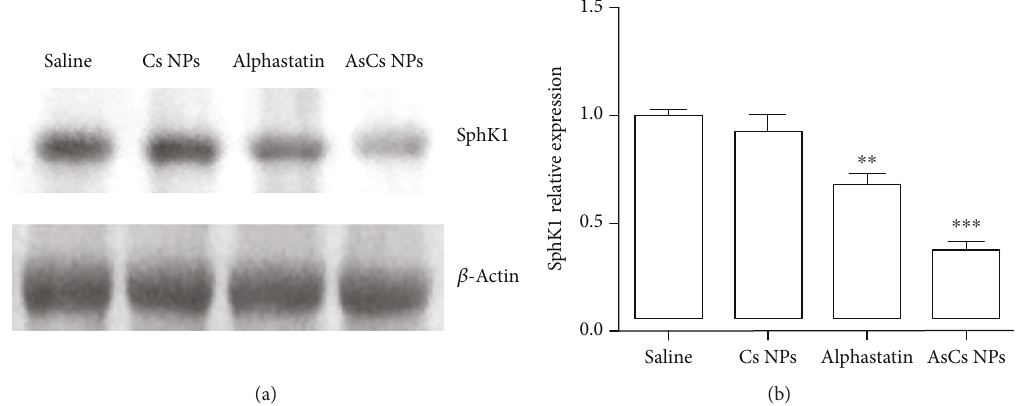
Figure 8: The downregulated SphK1 expression by AsCs NPs was detected by western blotting assay. (a) Representative images of SphK1. (b) The bar graphs show quanti fi ed levels of SphK1. ∗∗ P < 0 01 and ∗∗∗ P < 0 001 versus saline